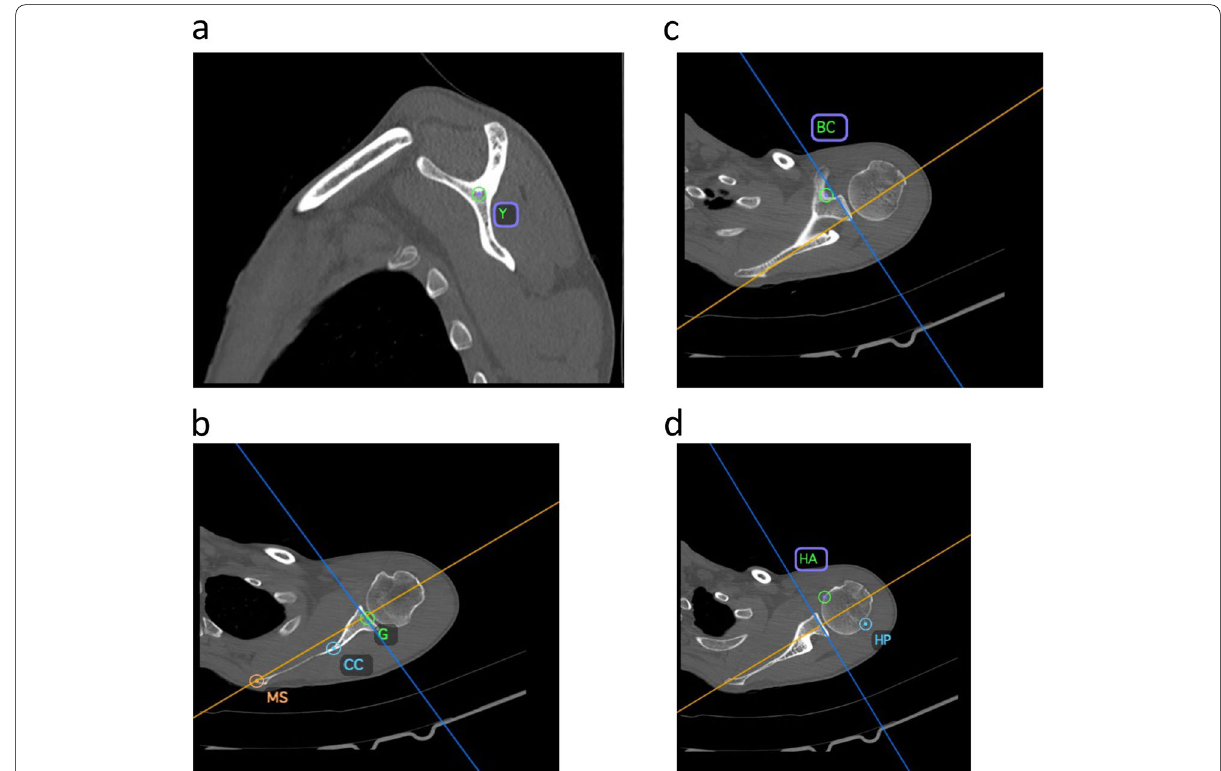
Fig. 2 The 7 following points were digitized and named on each CT scan: a The Y point was digitized in the parasagittal view, at the intersection of the 3 bone branches (Y) on the aforementioned ‘Y‑plane’; b The centre of the glenoid (G), the most medial point of the scapula (MS), and the cortical convergence (CC) of the anterior and posterior margins of the glenoid were all digitized in the same axial plane; c The base of the coracoid (BC) was digitized where the lateral cortex of the coracoid process merges with the cortex of the scapula in the axial view; d The anterior (HA) and posterior (HP) margins of the humeral head were digitized in the axial plane where the humeral head appeared to have the greatest